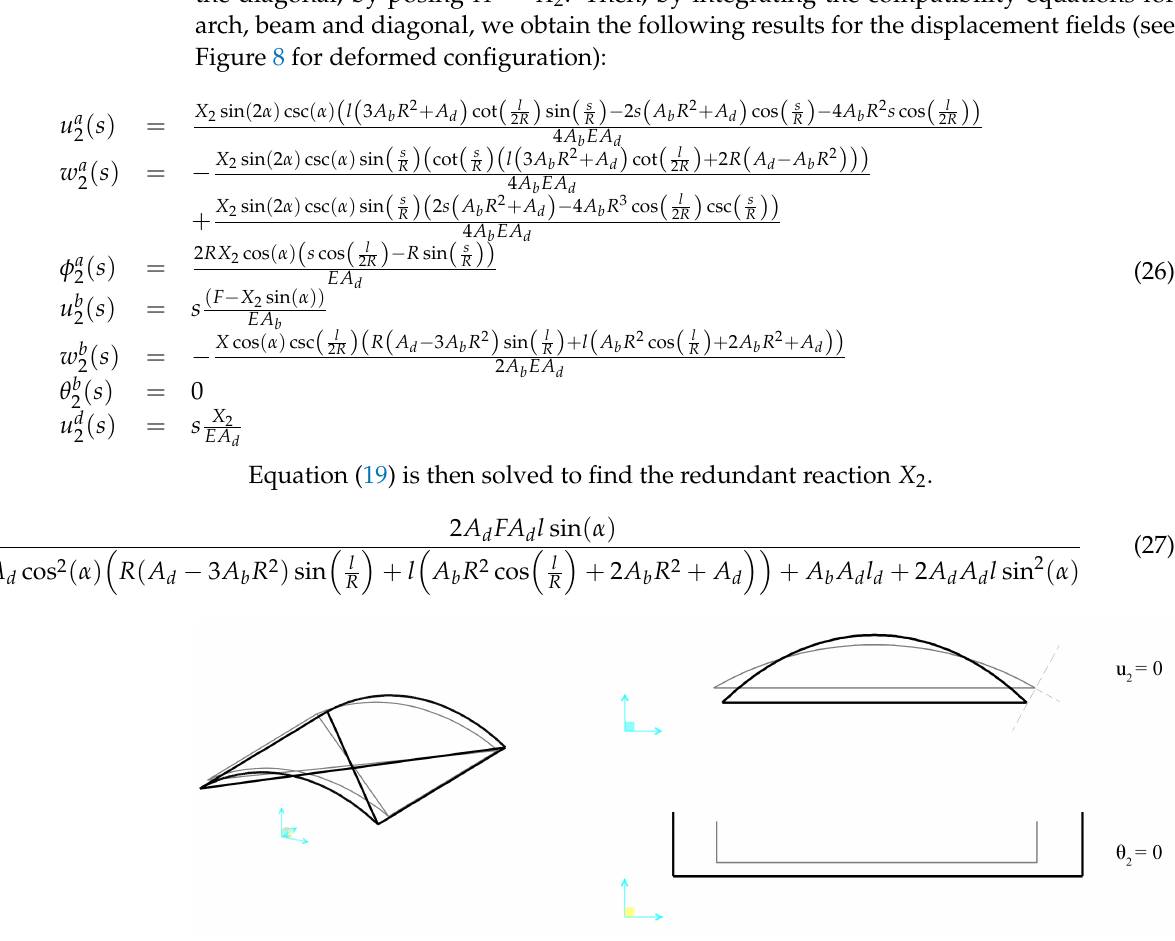
Figure 8. Deformed configuration of the problem